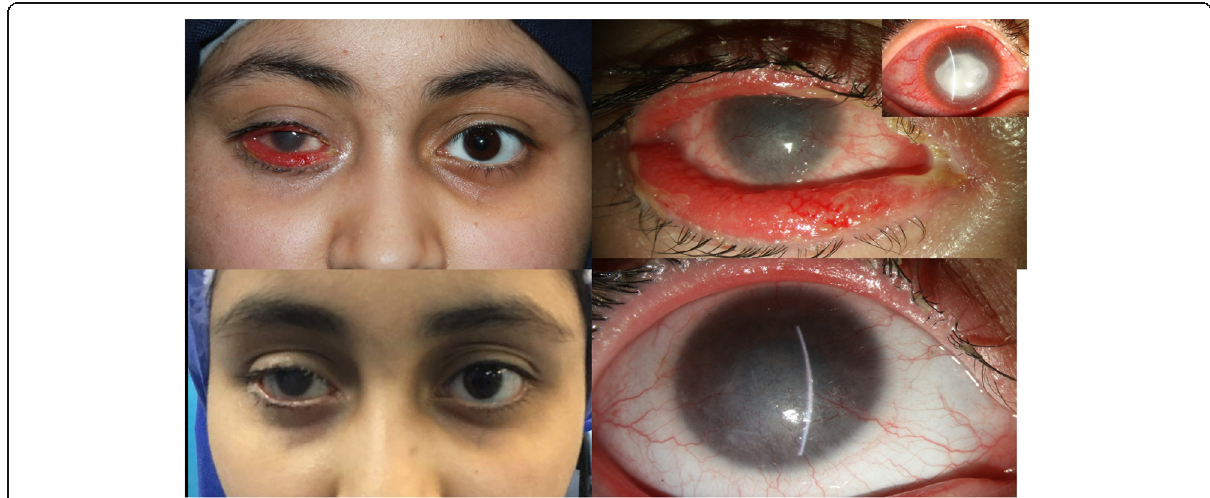
Fig. 1 a and b show ectropion and papillary conjunctival reaction after chronic use of Natamycin for fungal keratitis ( c ). d and e show resolution of right eye ectropion after cessation of topical